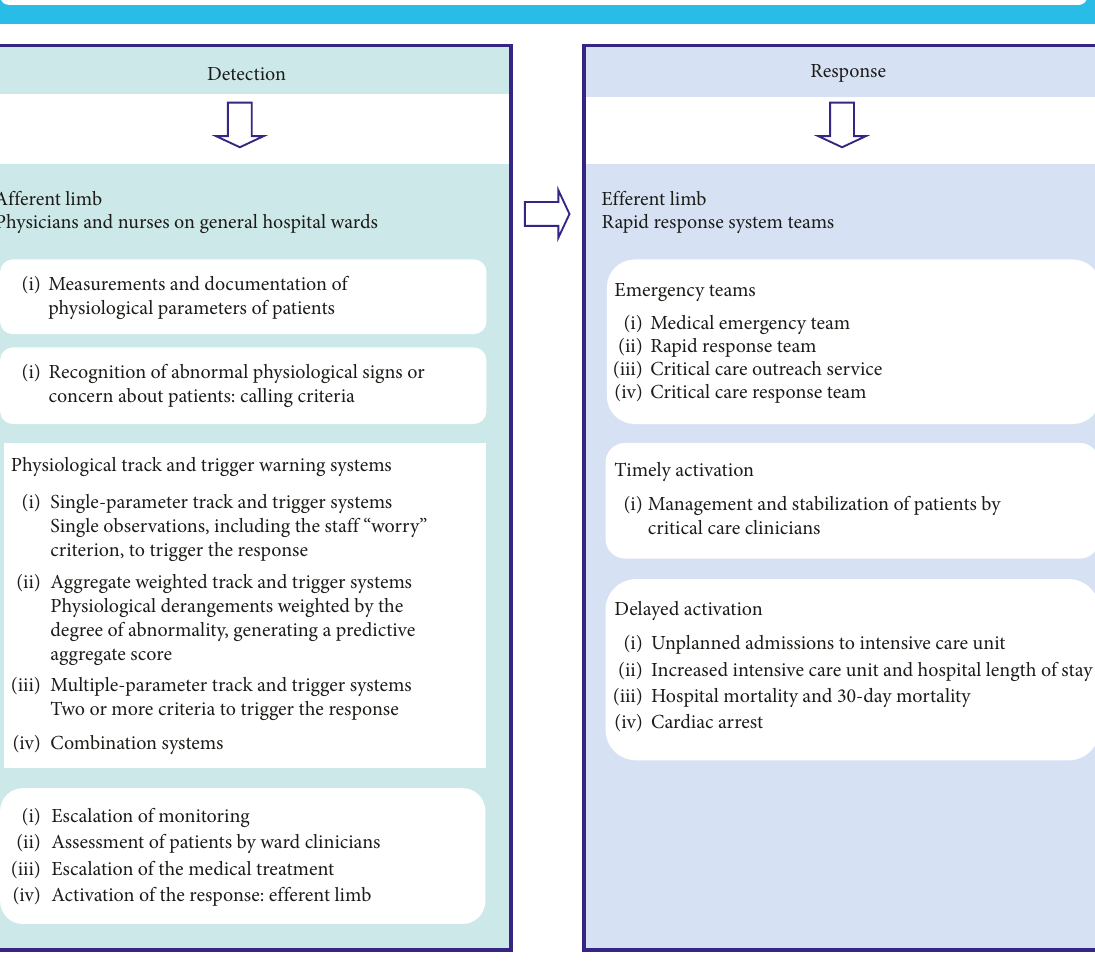
Figure 1: Rapid response systems and management of deteriorating ward